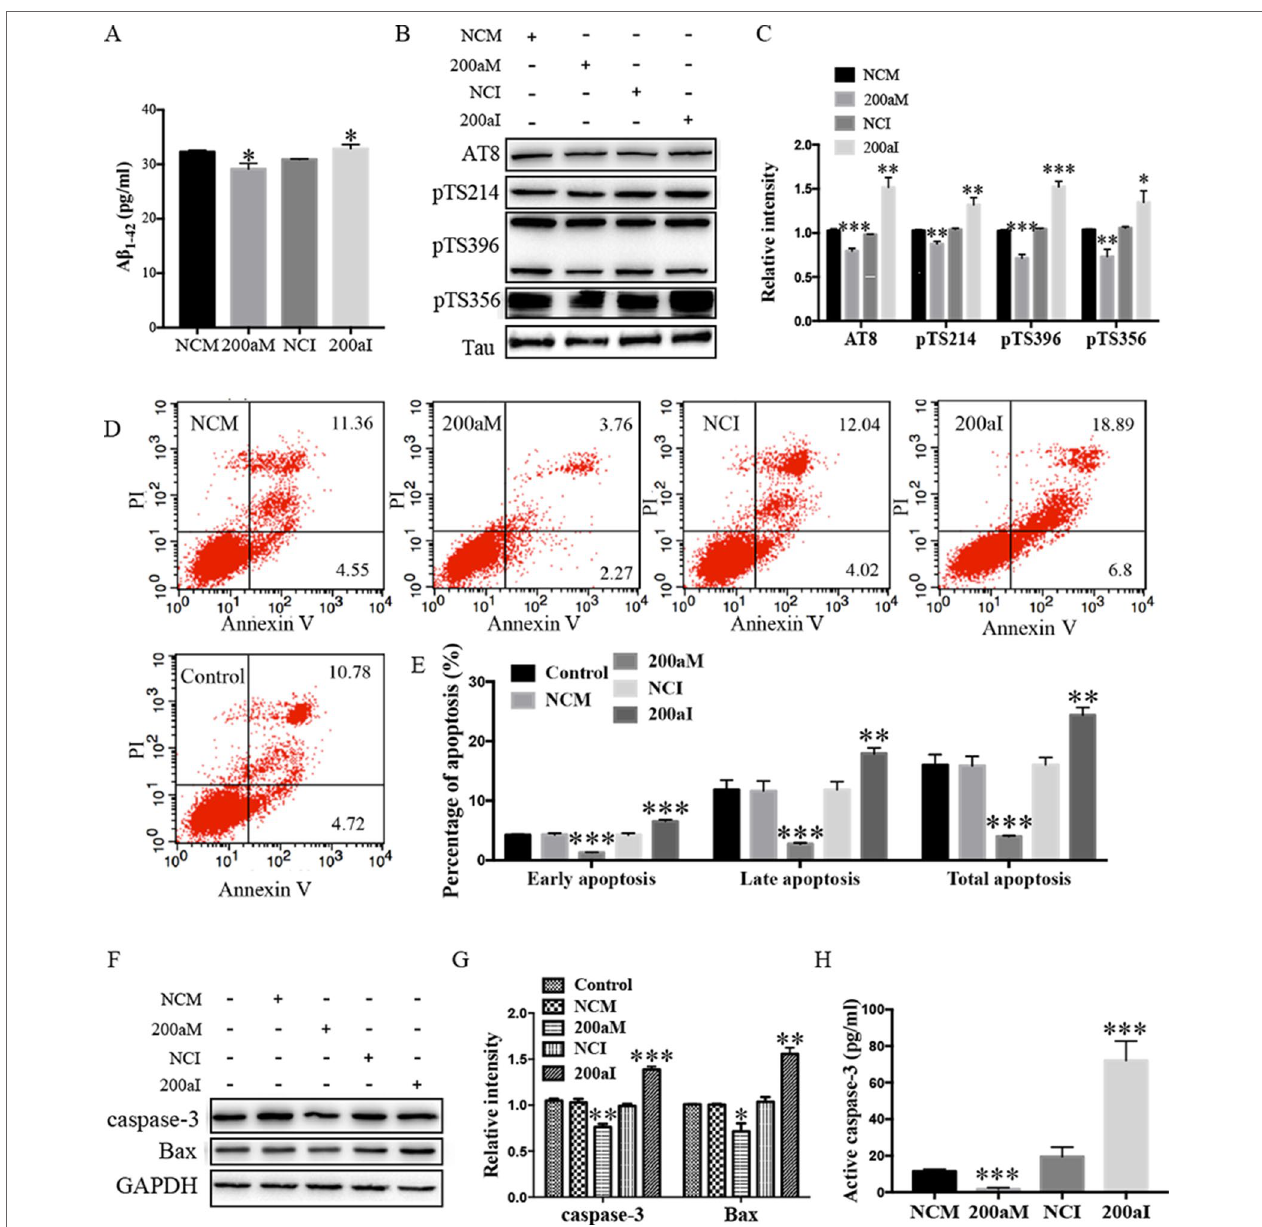
FIGURE 2 | The activity of miR-200a-3p exhibits neuroprotective properties in APPswe cells. (A) miR-200a-3p mimics (200aM) inhibited the production of A β 1-42 in APPswe cells whereas miR-200a-3p inhibitor (200aI) increased A β 1-42 production ( n = 4). (B , C) miR-200a-3p mimics (200aM) decreased the phosphorylated levels of tau at Ser202/Thr205 (AT8), Ser214 (pTS214), Ser396 (pTS396), and Ser356 (pTS356) sites, as demonstrated here with representative images (B) and quantitative analysis (C) by Western blotting ( n = 3). (D , E) Quantification of cell apoptosis in the presence of miRNA-200a-3p mimics (200aM), miRNA-200a-3p inhibitors (200aI), corresponding negative controls (NCM/NCI), and nontransfected controls (control) in APPswe cells, as demonstrated by representative images (D) and quantitative analysis (E) by flow cytometry ( n = 3). (F , G) miR-200a-3p mimics decreased the expression of caspase-3 and Bax, as demonstrated here by representative images (F) and quantitative analysis (G) by Western blotting. (H) miR-200a-3p mimics decreased the activity of caspase-3 in APPswe cells ( n = 4). Data are shown as the mean ± SEM. *P < 0.05, ** P < 0.01, ***P < 0.001 versus relative